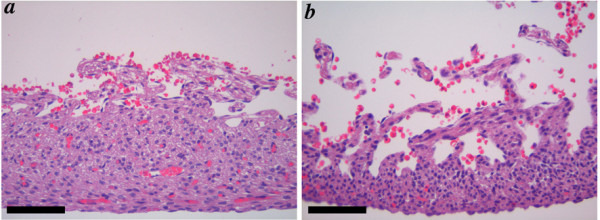
Myocardial wall malformations in Ptdsr-/- embryos (a, b) Sagital sections of wild-type (a) and homozygous mutant (b) embryos at 16.5 dpc revealed a thinning of the myocardial wall (compact zone) and an increased myocardial trabeculation (b) in the mutant heart. Scale bar = 100 μm.